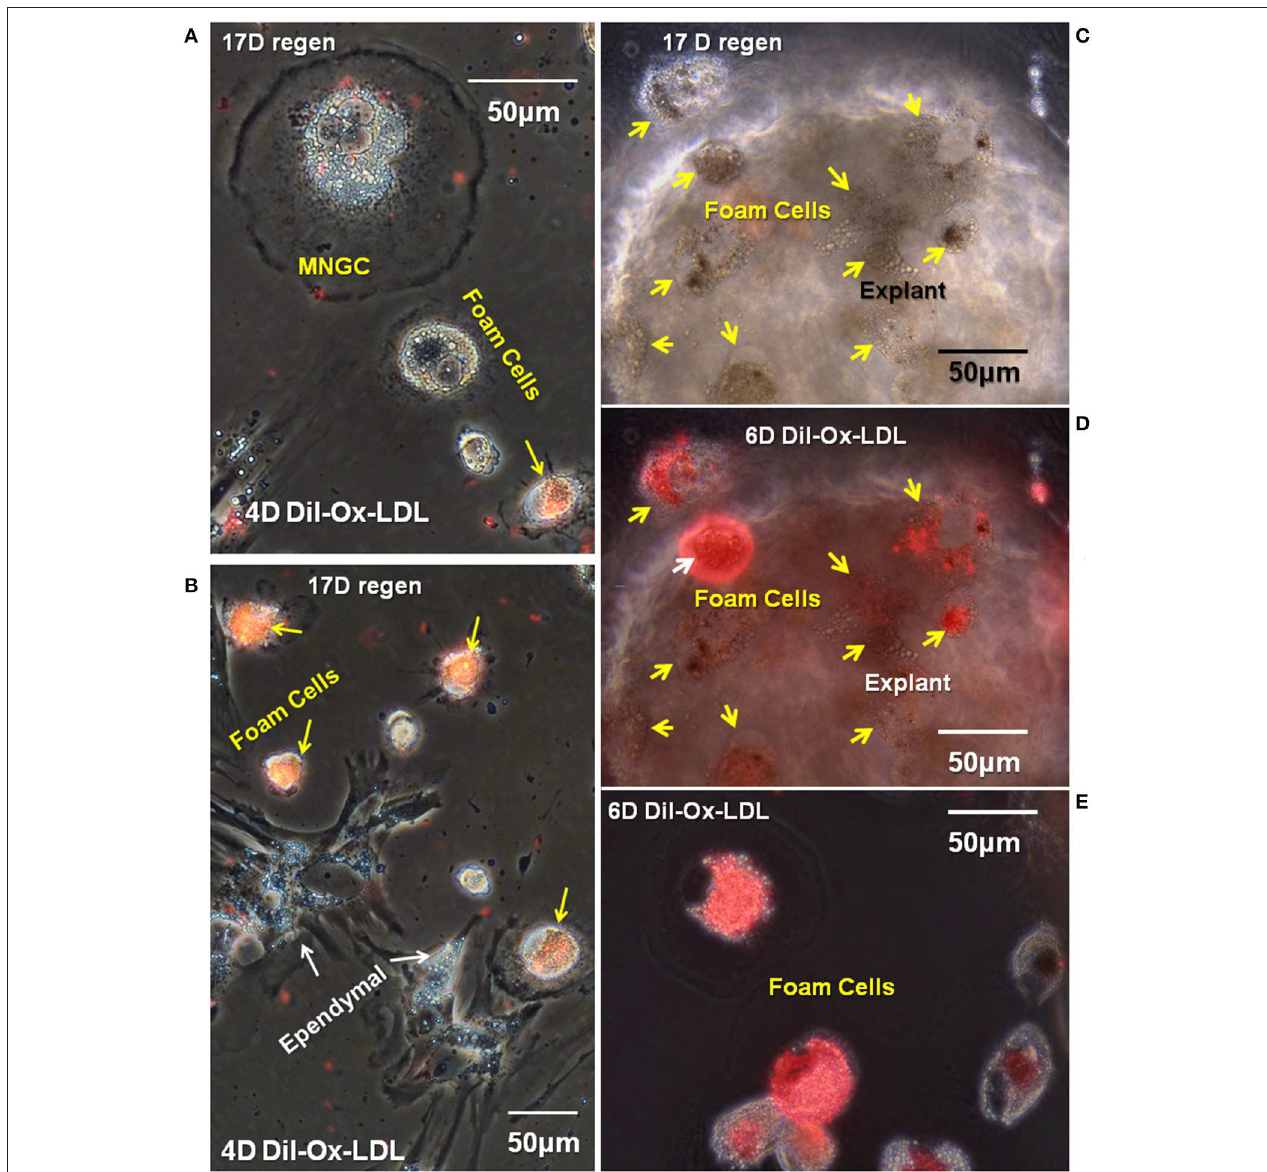
FIGURE 7 | A subpopulation of foamy macrophages takes up DiI-labeled oxidized low-density lipoprotein receptor. Seventeen days cord regenerates were cultured for 11 days in vitro (A,B) or 17 days in vitro (C–E) and were treated with DiI-Ox-LDL for 4 days (A,B) or 6 days in vitro (C–E) . MNGCs and ependymal cells (white arrows) were not labeled; however, a subpopulation of foamy macrophages (yellow arrows) were labeled. (C,D) Are the same field, with the explant shown in phase contrast in (C) and overlaid with fluorescence to highlight the foamy macrophages that have taken up DiI-Ox-LDL (yellow arrows). (E) Shows foamy macrophages that have migrated out of the explants and taken up DiI-Ox-LDL in culture. D, day; Regen, regeneration. Magnification bar is shown in the upper portion of images A and E, and the lower portion of images (B–D) .